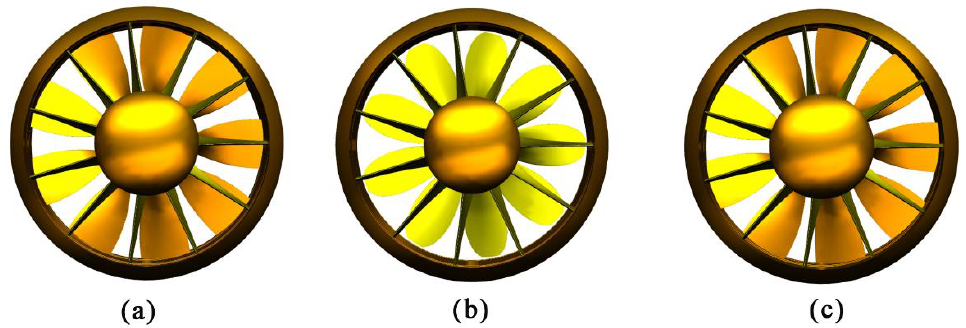
Figure 8. Pump-jet propulsion model designed by direct method: ( a ) lifting method; ( b ) lifting-line method; ( c ) optimal model.